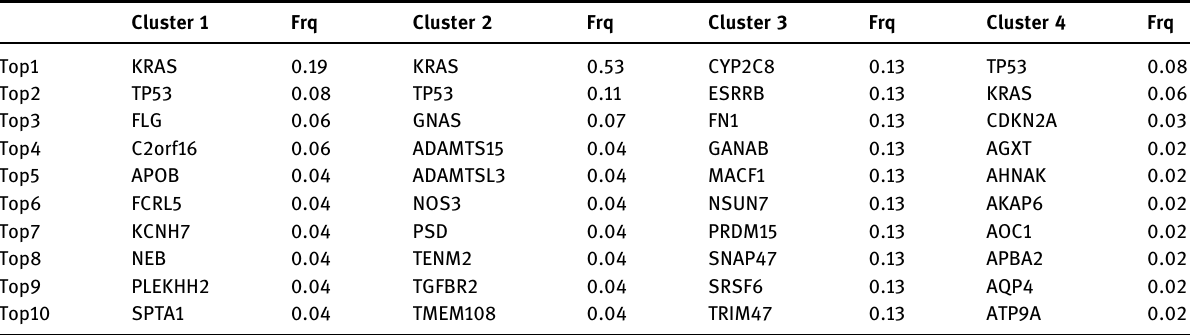
Table 3: Top 10 mutated genes in di ff erent